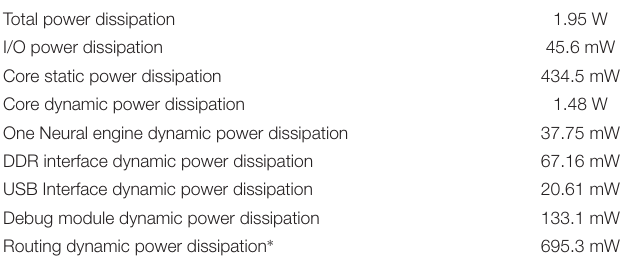
TABLE 4 | FPGA’s power dissipation estimated by PowerPlay.